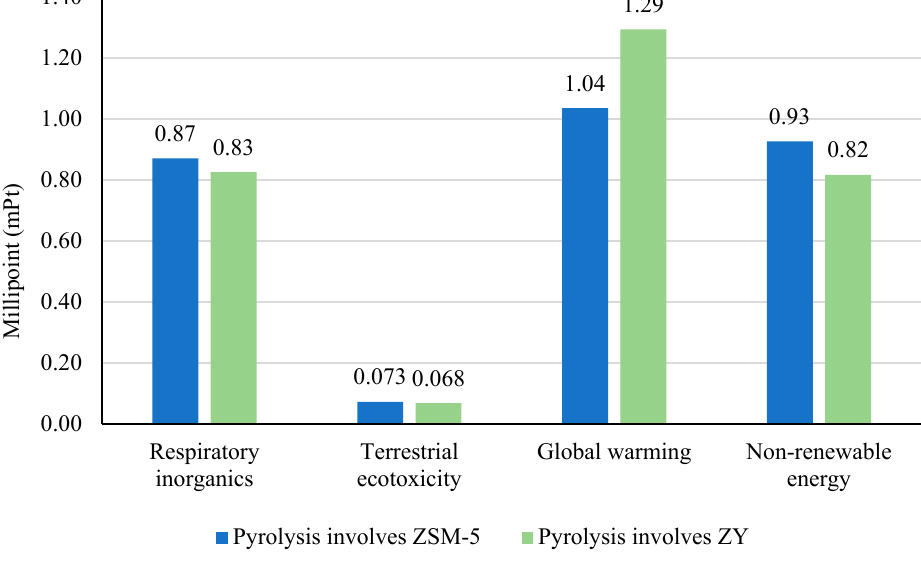
Figure 4a.Contribution of GHG emissions in pyrolysis involved ZSM-5 catalyst.